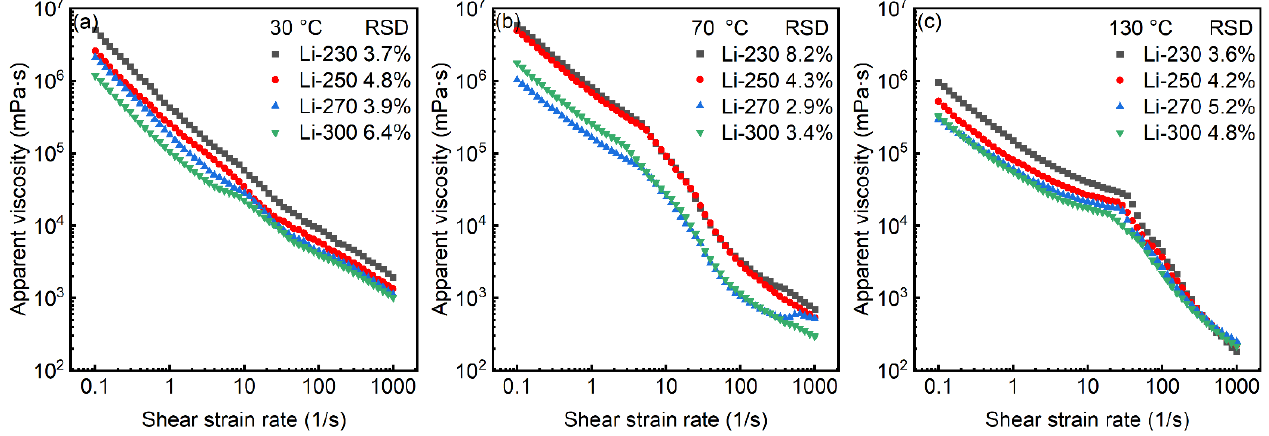
Figure 3. Variations in apparent viscosity with shear strain rate of lithium grease with different consistencies at different temperatures: ( a ) 30 °C, ( b ) 70 °C, ( c ) 130 °C.